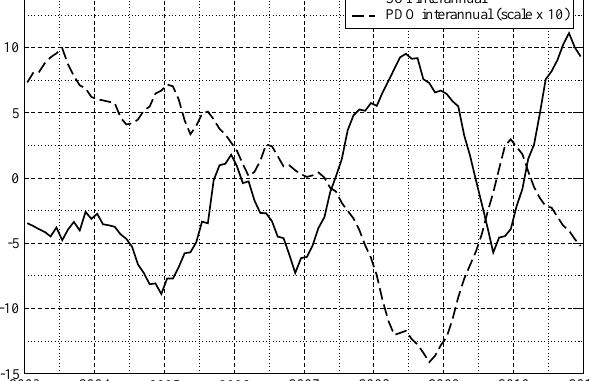
Fig. 7. (a) Temporal components of PCA 1st orthogonal mode. (b) Interannual variations of the Southern Oscillation Index (SOI) and Pacific Decadal Oscillation (PDO).